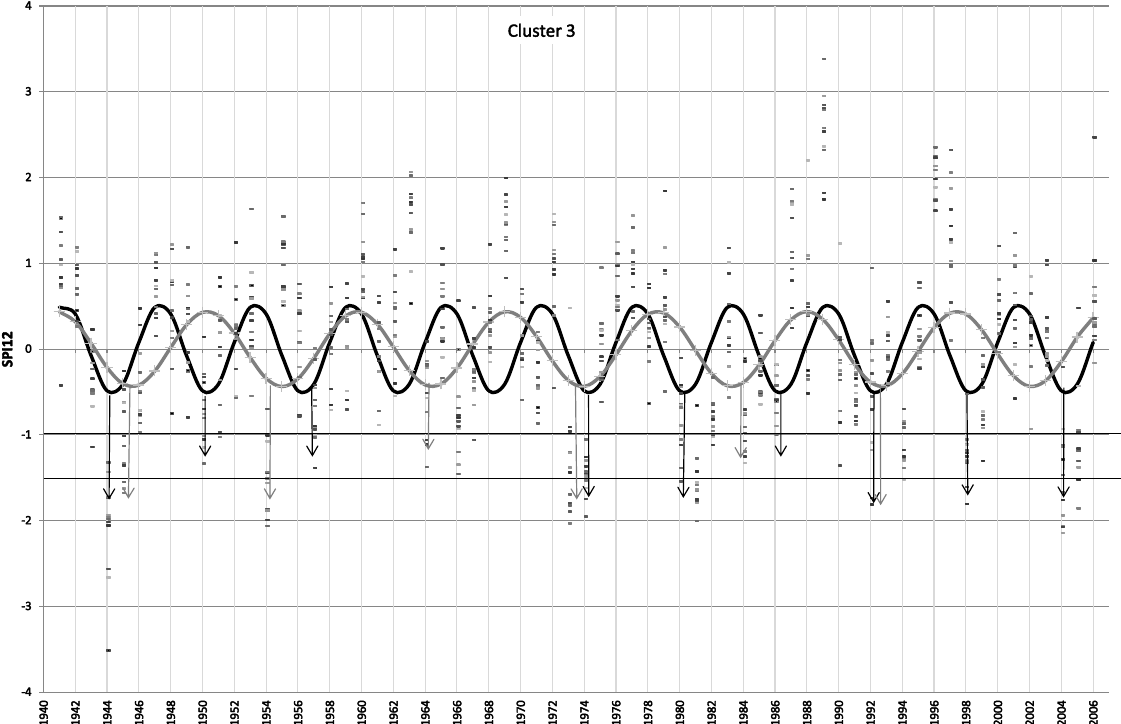
Figure 6. SPI-12 December values for southern Portugal (cluster 3) + waves of period 6 (black line) and 9.4years (grey line).